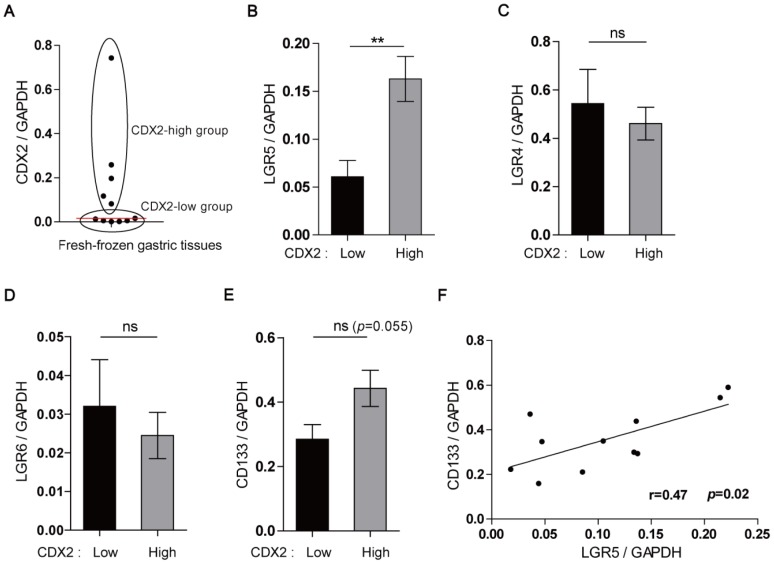
Increased LGR5 expression with gastric intestinalization.Semi-quantitative real-time PCR was performed with fresh-frozen normal gastric tissues (n = 11) to analyze the expression of LGR4, LGR5, LGR6, CDX2, and CD133. (A) The samples were divided into the CDX2-high and -low groups according to the median CDX2 value (red line). LGR5 expression was significantly higher in the CDX2-high group (B), whereas there were no differences in the levels of LGR4 (C) and LGR6 (D) between the groups. (E) CD133 expression was higher in the CDX2-high group, although this was not statistically significant (p = 0.055). (F) A positive correlation was observed between LGR5 and CD133 expression (Pearson correlation coefficient  =  0.47, p = 0.02).